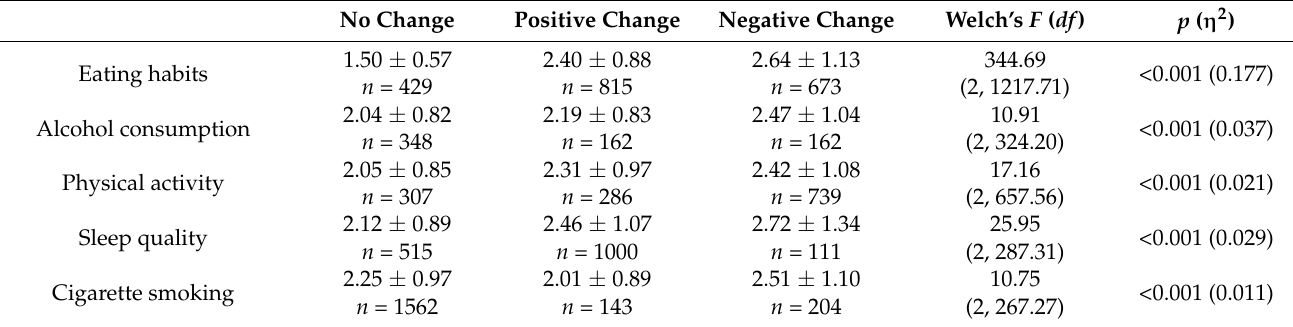
Table 5. Differences in emotional eating due to change in lifestyle